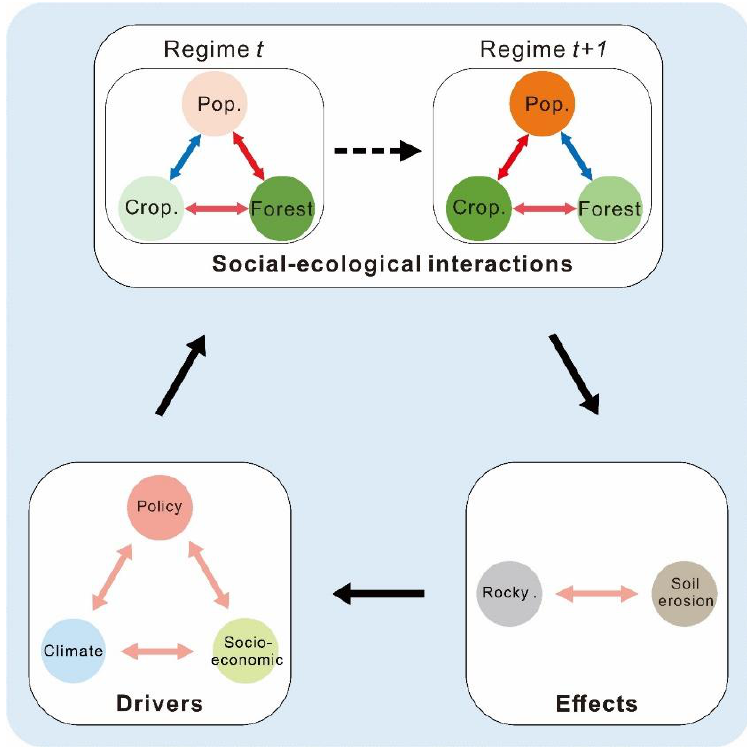
Figure 2. Framework for understanding the evolution of a karst SES.